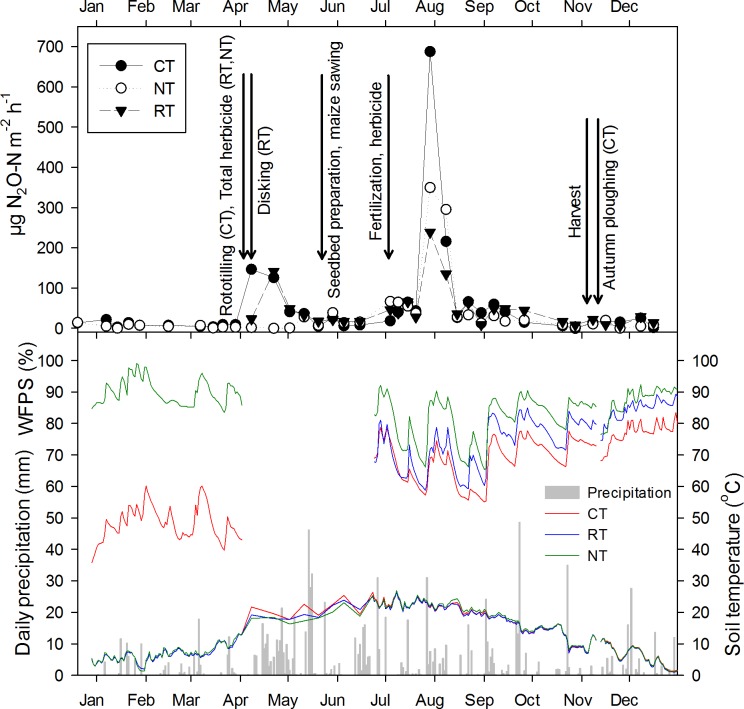
a Mean N2O emissions per treatment (n = 4) and b daily precipitation, and mean soil temperature and moisture in 5 cm depth in CT, NT and RT treatments in 2014. Error bars are omitted to maintain readability.